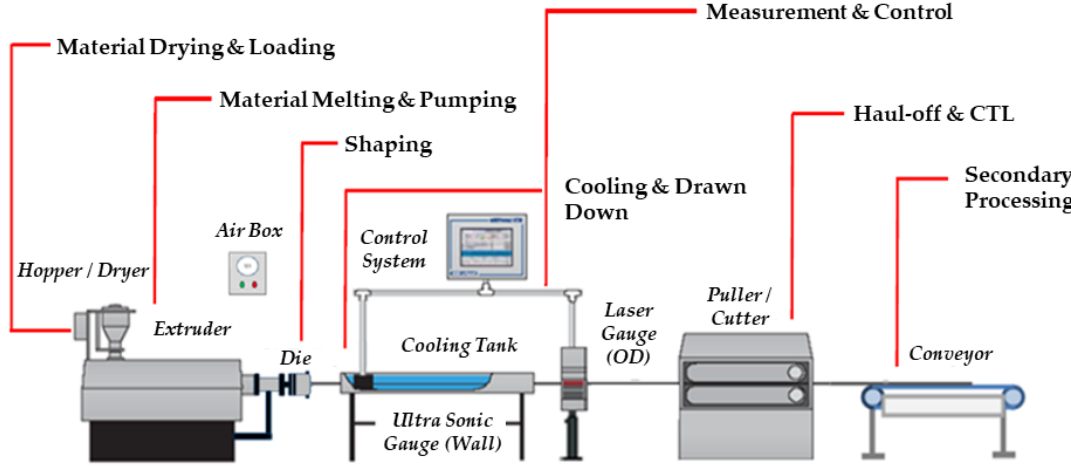
Figure3. Figure 3. Schematic of tube extrusion process including an extruder and down-stream ancillary equipment.